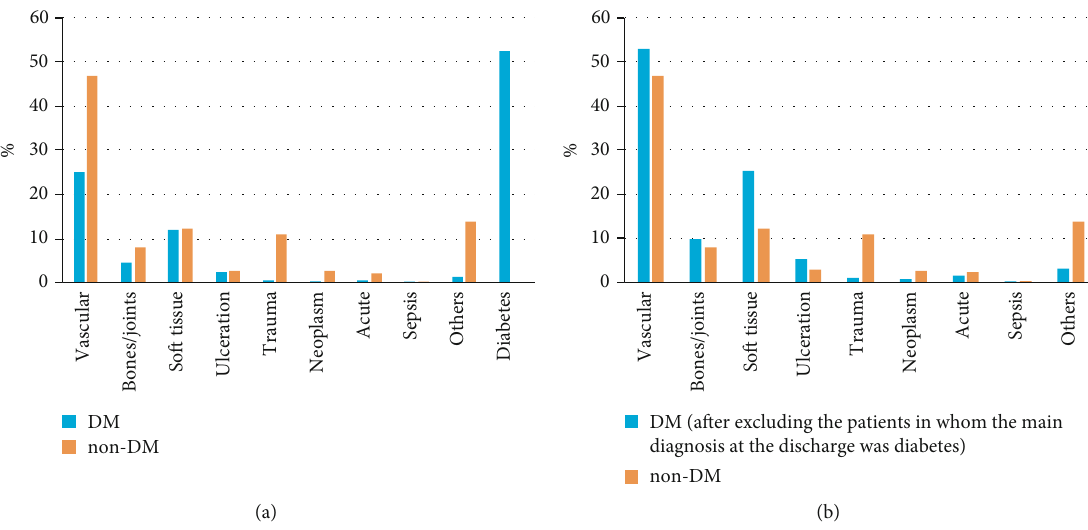
Figure 2: (a) Percentage number of ICD-10 categories given as the main diagnosis at the discharge from the hospital after the amputation in all study population and (b) in population after excluding the patients in whom the main diagnosis at the discharge was diabetes. Table 2: Thirty-day mortality according to diagnosis at discharge categories in patients with and without diabetes. Patients with diabetes Patients without diabetes Category Number of amputations Number of deaths (%) Number of amputations Number of deaths (%)